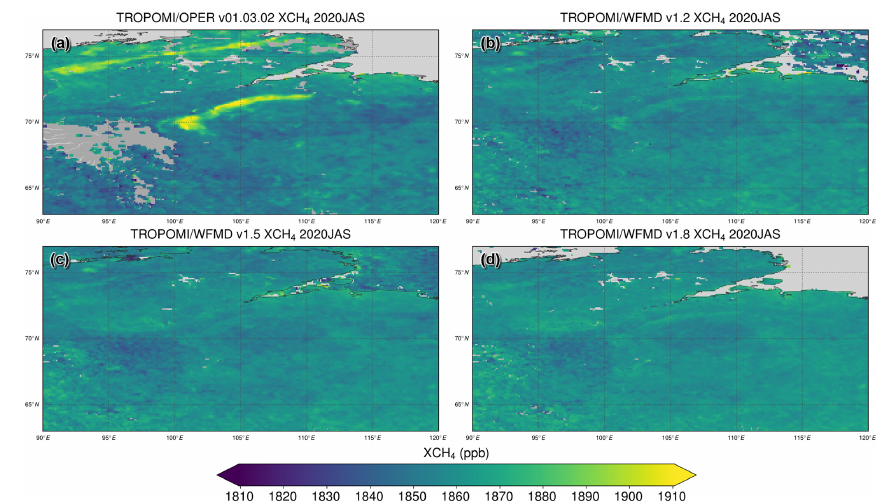
Figure 1. Comparison of the XCH 4 distribution in July–September 2020 over the northern Siberian Taymyr region for (a) the operational product and (b–d) different TROPOMI/WFMD versions (v1.2 and v1.5 use a quadratic polynomial, while v1.8 uses a cubic polynomial). The strong artificial enhancement in the operational product, which is largely reduced when using a cubic polynomial (Lorente et al., 2022), is hardly visible at all in the TROPOMI/WFMD products even if using a quadratic polynomial.